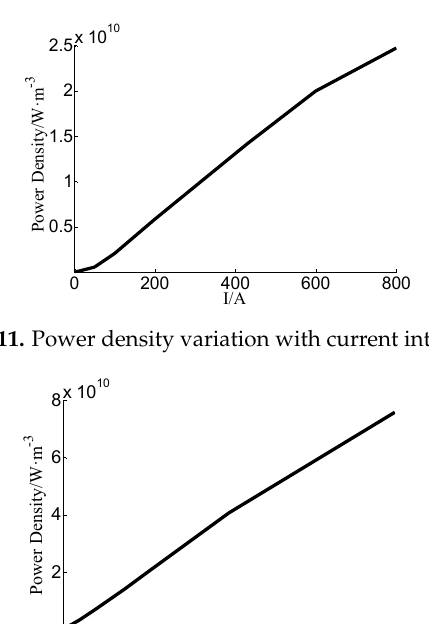
Figure 10. Power density profile in the surface of the heated workpiece (I = 430 A, f = 37.6 kHz) [8].